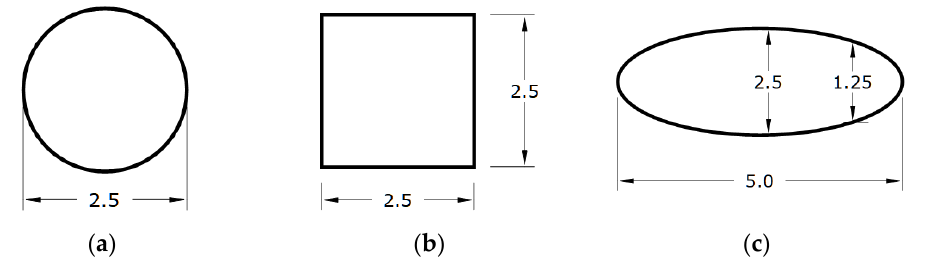
Figure 5. Dimension of different piles (all dimensions are in cm): ( a ) circular; ( b ) square; ( c ) lenticular.